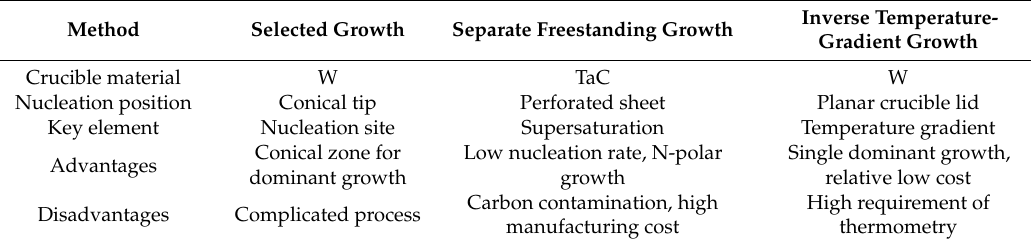
Table 1. Comparison of three strategies for AlN bulk